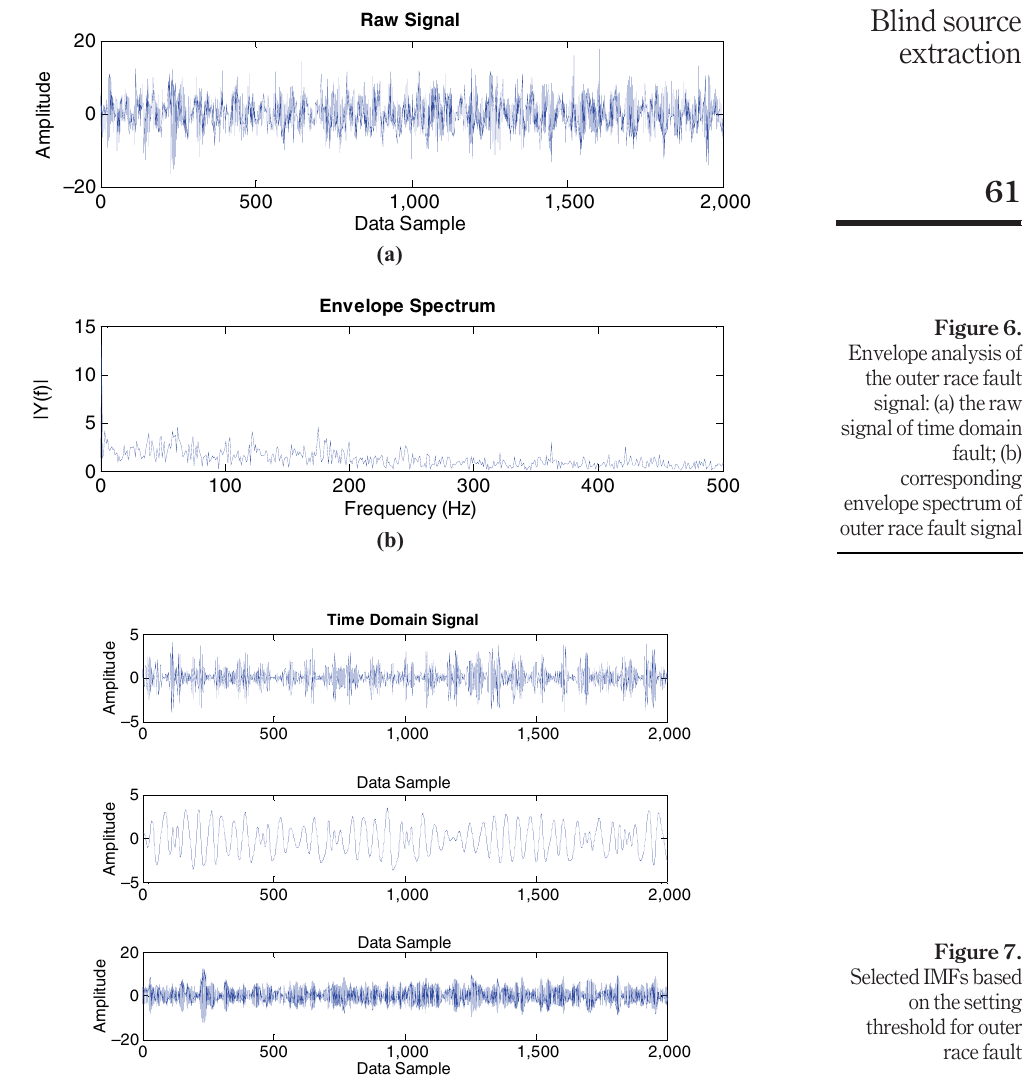
Figure 6. Envelope analysis of the outer race fault signal: (a) the raw signal of time domain fault; (b) corresponding envelope spectrum of outer race fault signal